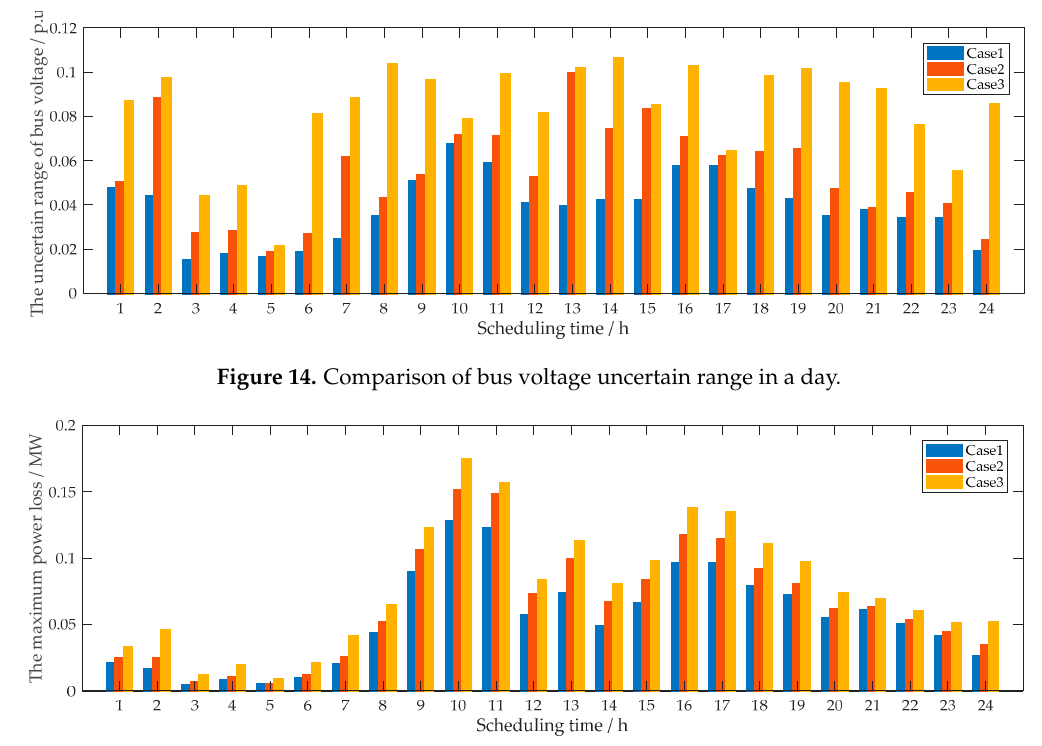
Figure 15. Comparison of maximum power loss in a day.